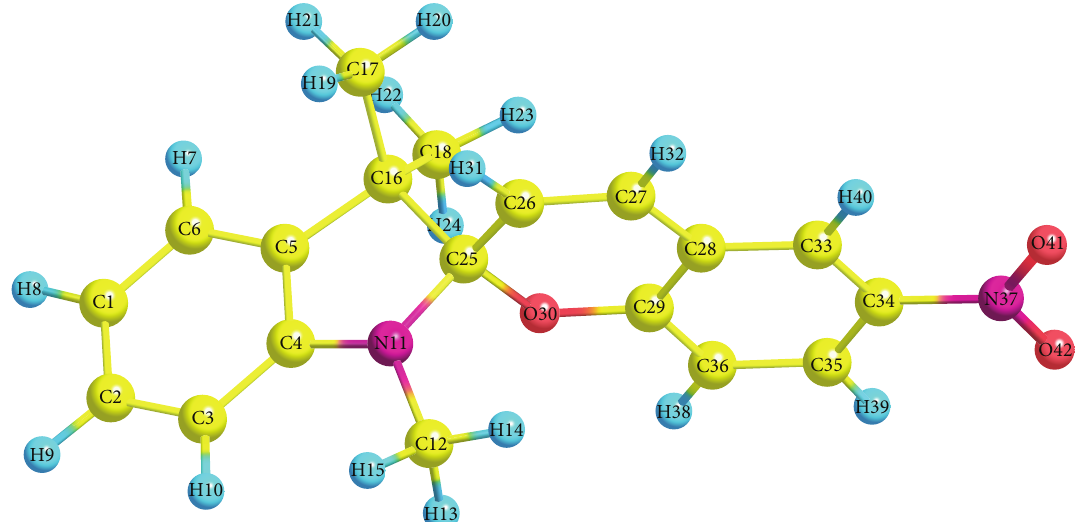
Figure 1: General structure of the